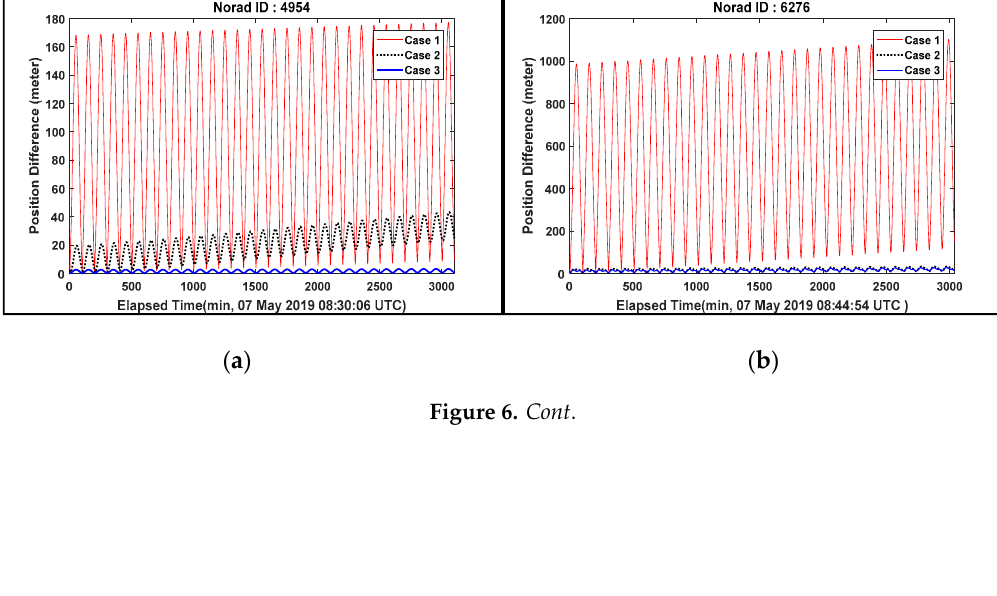
Table 8. The 3D position difference (m) RMS of 1-day arc angle data from two